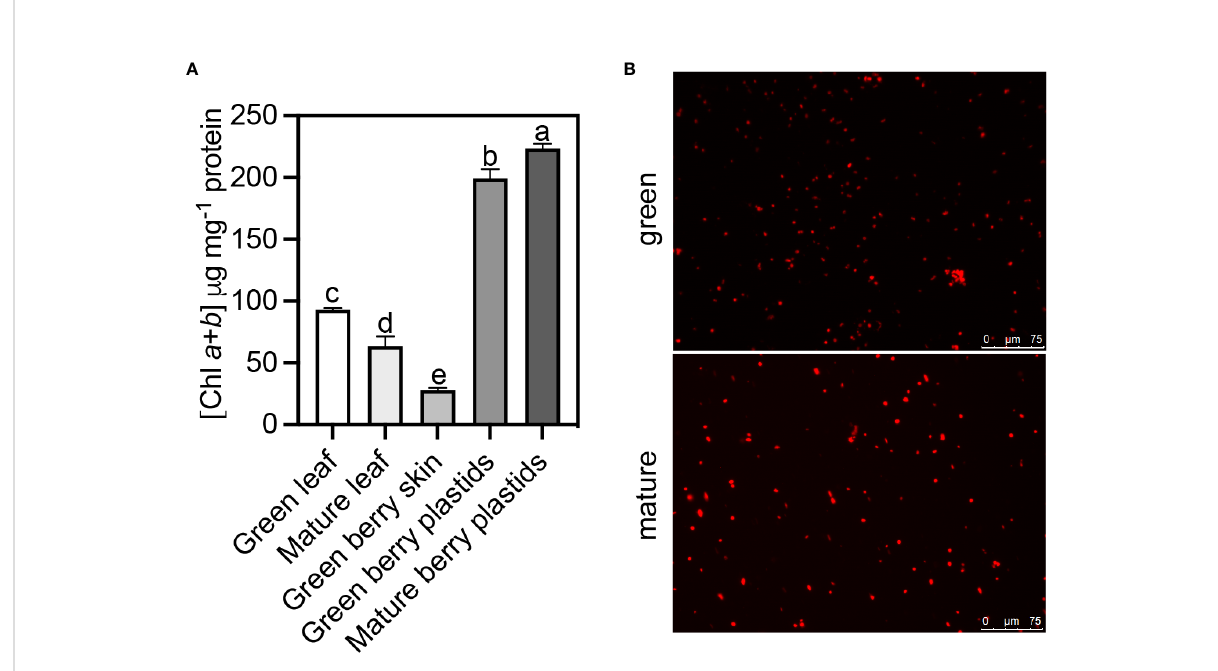
FIGURE 2 Plastid puri fi cation from the exocarp of Vitis vinifera cv. Vinhão at green (E-L 34) and mature (E-L 38) developmental stages. (A) Total chlorophyll content (a + b) present in grapevine leaves at the green and mature stages, in berry skin at the green stage, and in the puri fi ed plastids of grape berry skin at the green and mature stages of development and (B) visualized by fl uorescence microscopy. One-way ANOVA with Tukey ’ s post-hoc test; different letters denote statistical differences between